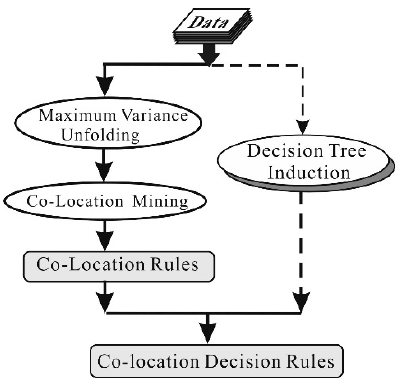
Figure 5. The flowchart of the experiment.